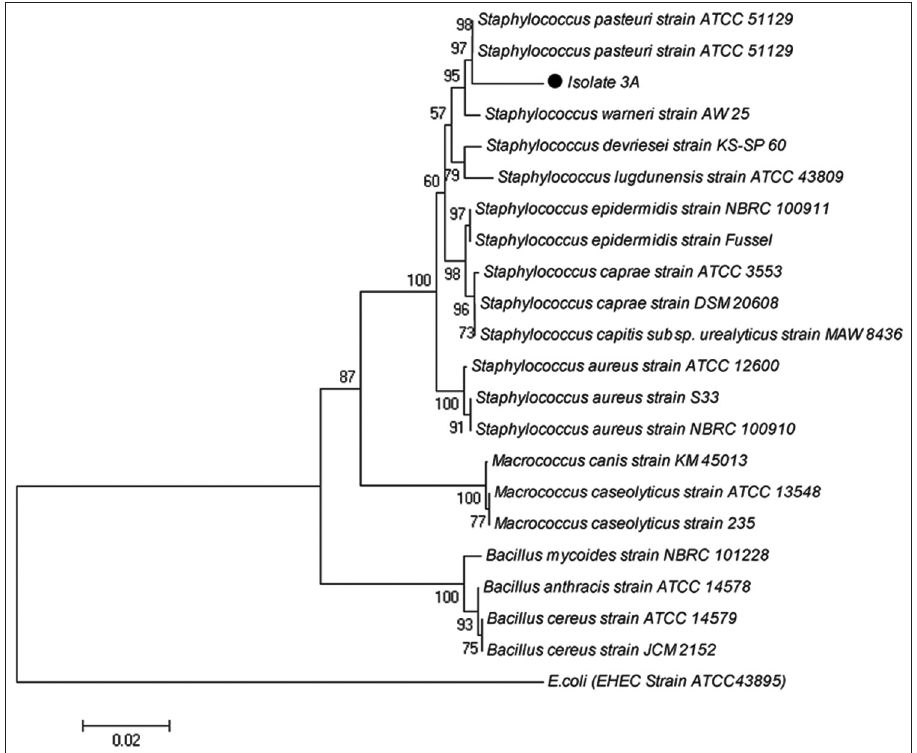
Figure-2: A phylogenetic tree indicating the position of Aceh cattle preputial swab isolate